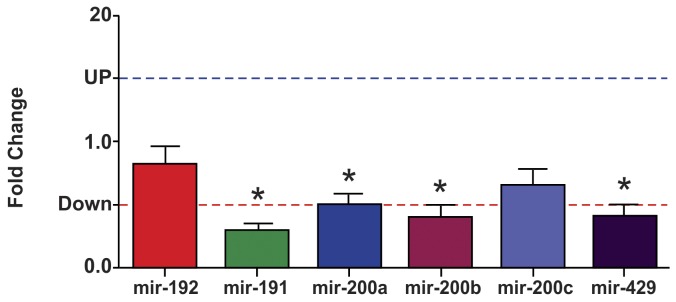
Expression of the miR-200 family and miR-192.
Expression levels of mir-192, mir-141, mir-200a, mir-200b, mir-200c and mir-429 estimated by TaqMan RT-qPCR in isolated glomeruli of 16-wk old LP rats. The expression of each microRNA was normalized for U6 and U87 genes. Data are expressed as fold change (mean ± SD, n = 5) relative to control group (n = 5). *Significantly different from control group (P≤0.05).